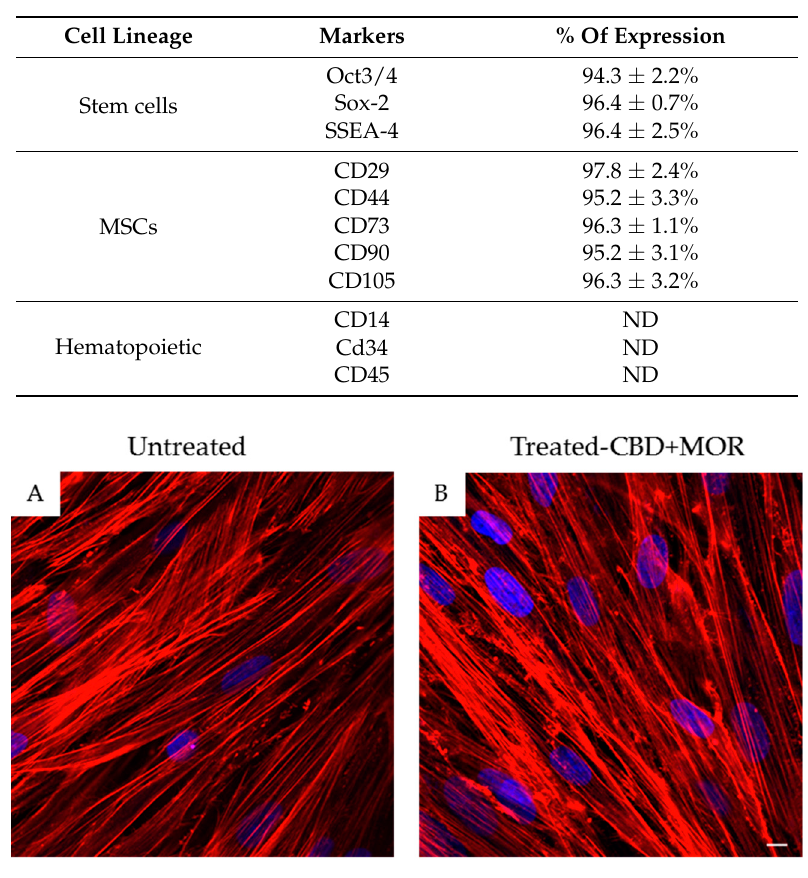
Table 1. Cytofluorimetric analysis of hPDLSCs. In the table, were reported: cell typology, specific markers, and percentage of expression of each marker. All markers of stem cells and mesenchymal stem cells were expressed on the surface, while hematopoietic cell markers were not expressed.